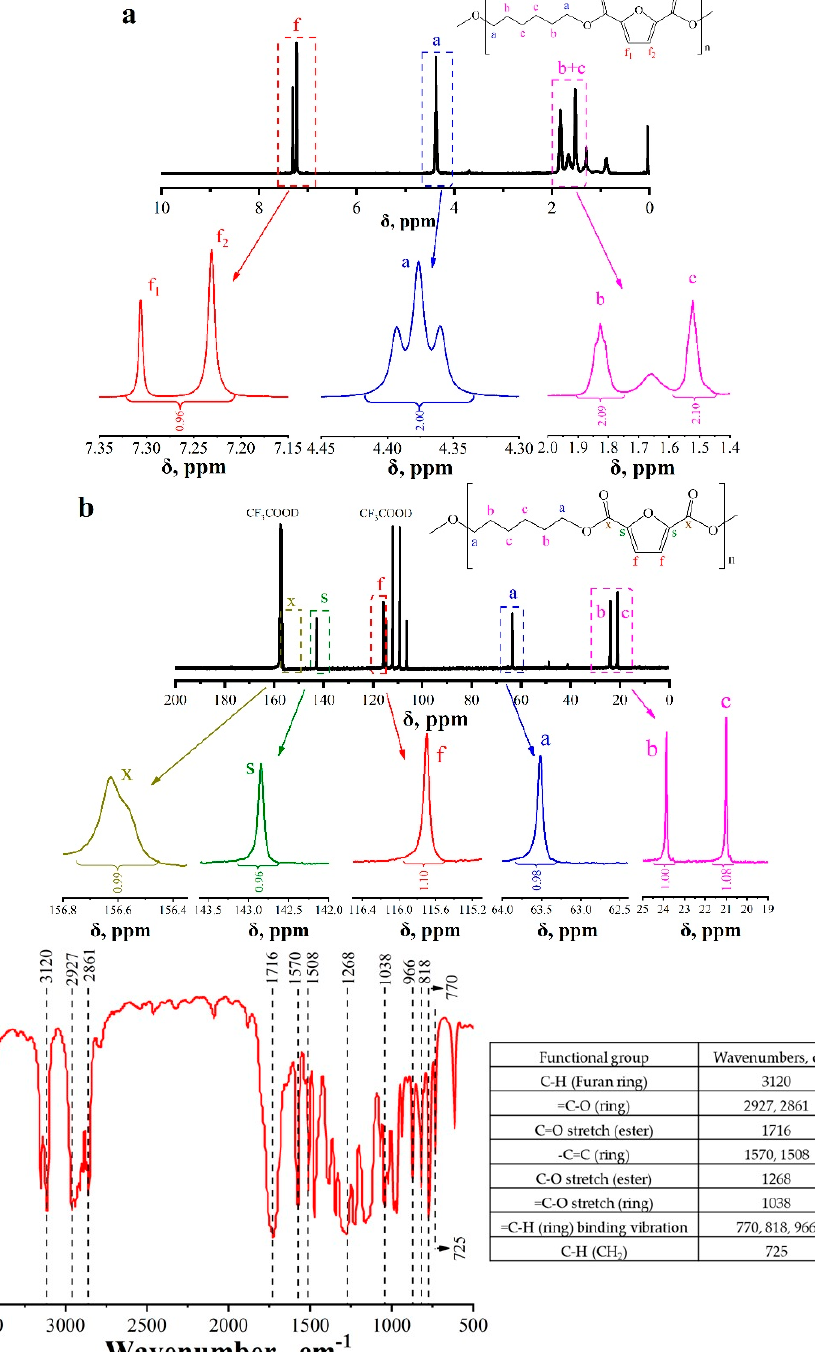
Figure 3. The structure of PHFs. ( a ) 1 H Nuclear Magnetic Resonance ( 1 H NMR) spectrum; ( b ) 13 C NMR spectrum; and, ( c ) Fourier-transform Infrared (FTIR) spectrum and peak assignments.